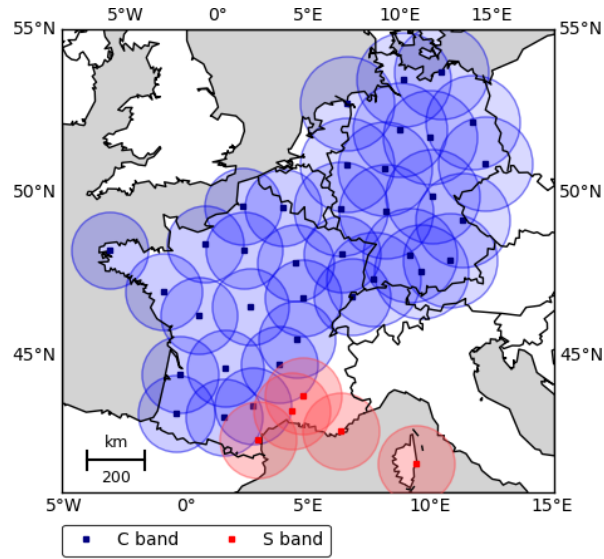
Figure 2. Locations (squares) and coverage of the radar stations (circles) in 2014 used in this study. See text for further